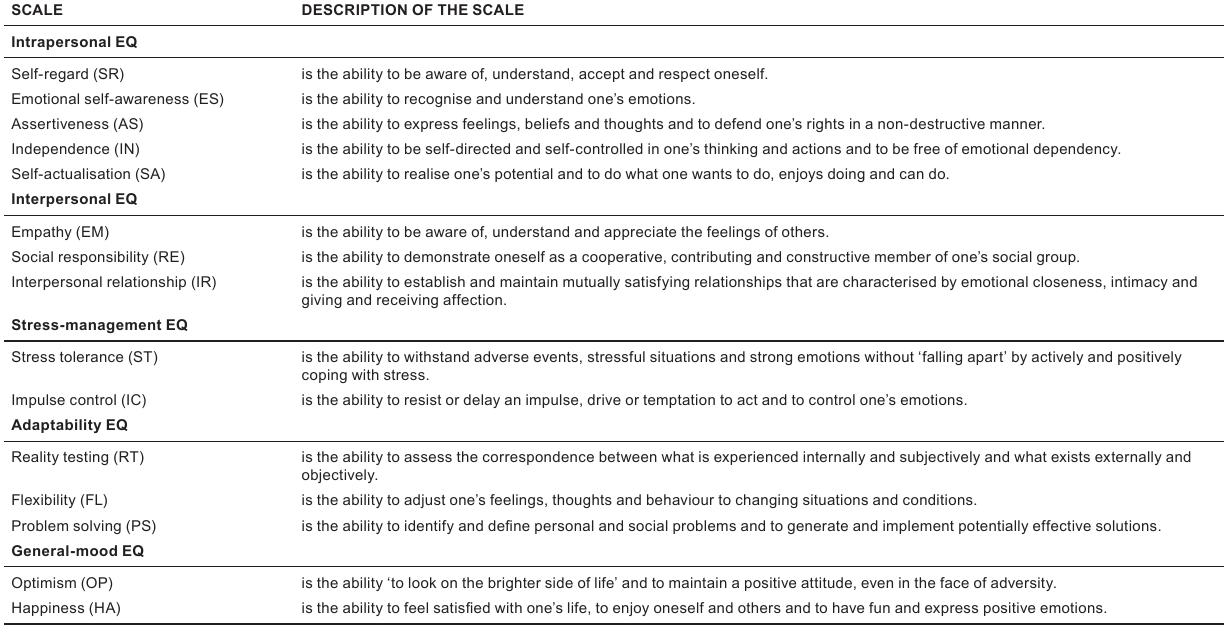
FIGuRE 1 Emotional intelligence model by Bar-On (1997),